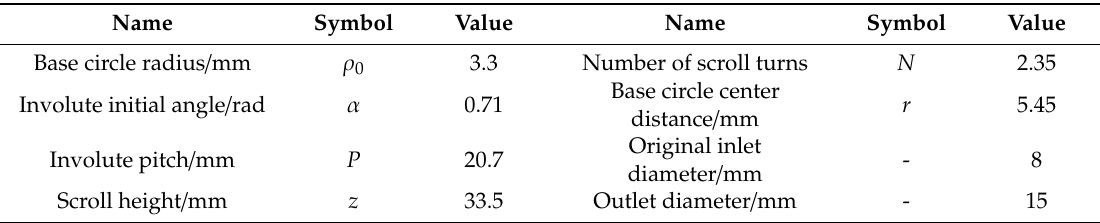
Table 1. The main structural parameters of the scroll